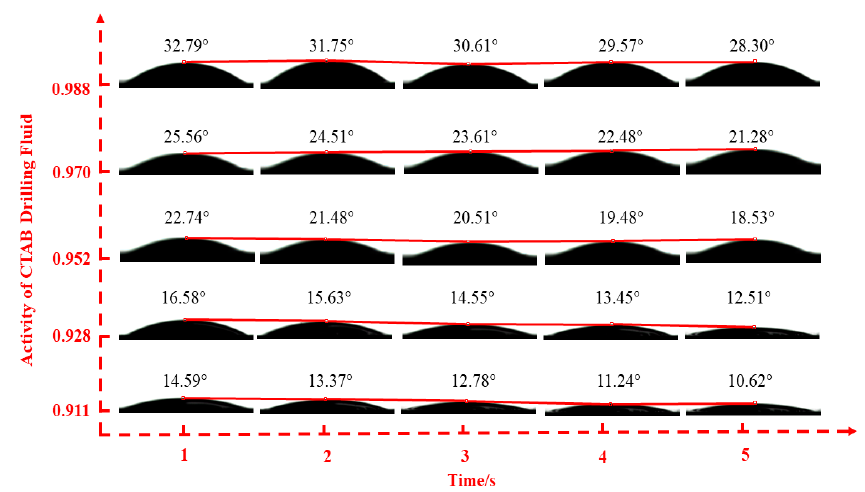
Figure 4. The evolution of fluid–shale contact angle for di ff erent activities of cetyltrimethylammonium Figure 3. The evolution of fluid–shale contact angle for different activities of bromide (CTAB) drilling fluid. Energies 2018 , 11 , x FOR PEER REVIEW cetyltrimethylammonium bromide (CTAB) drilling fluid.